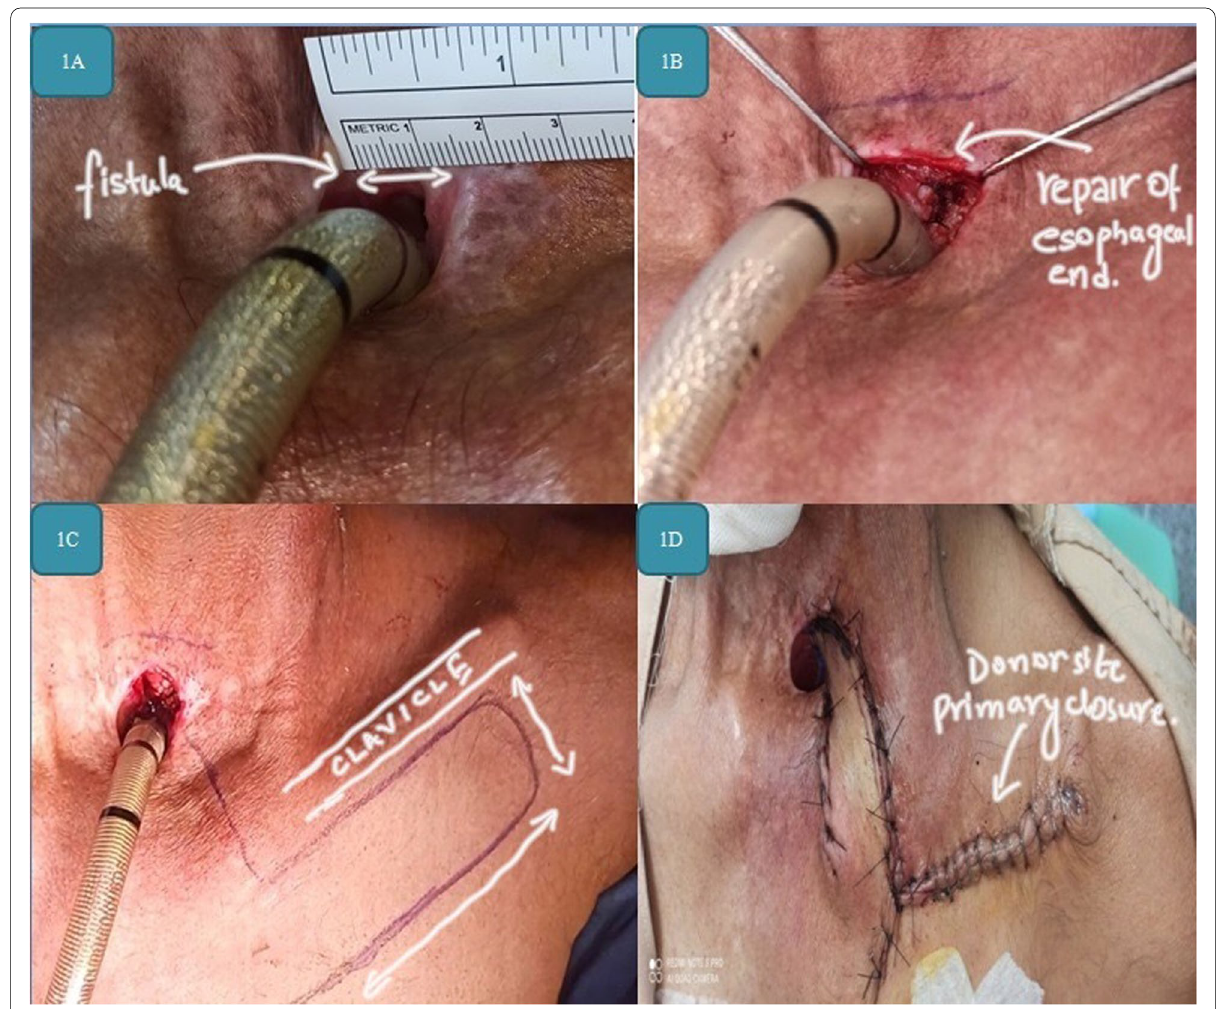
Fig. 1 A Size of the fistula. B Primary esophageal closure. C Flap designing. D Flap